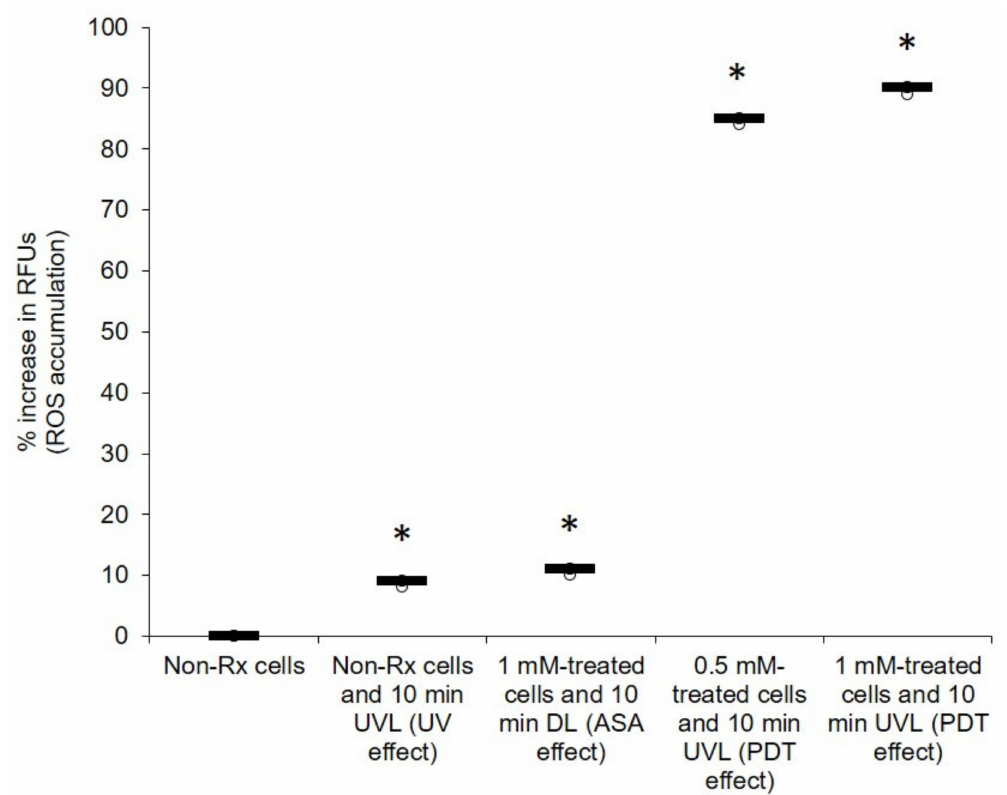
Figure 7. PDT action of ASA impairs the mitochondrial electron transport chain leading to excessive ROS production in C. neoformans LMPE 046. The background signal of negative controls was used for normalisation. There was a normality of data distribution. Non-Rx, non-treated cells; UVL, ultraviolet light; DL, dark light; RFUs, relative fluorescence units. Data points were obtained from three biological replicates for each defined experimental condition. * Significantly different from non-Rx cells at p <